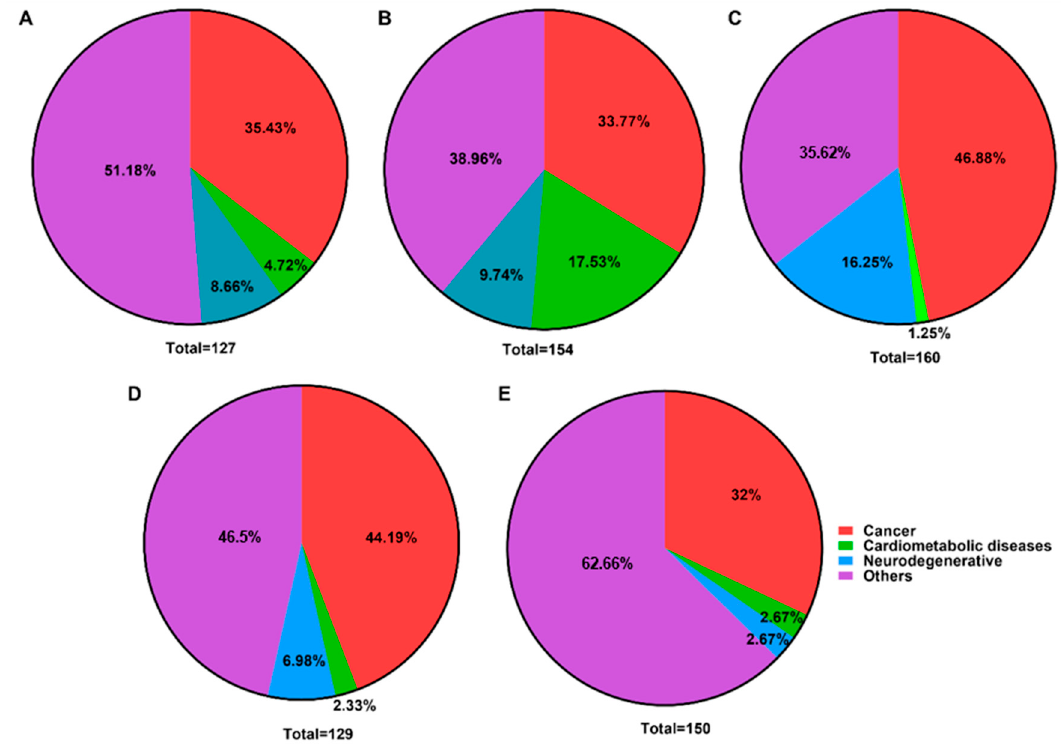
Figure 6. Percentages of diseases associated with each therapeutic target of evaluated compounds. Numbers on each pie chart indicate the corresponding BCC in Figure 1.